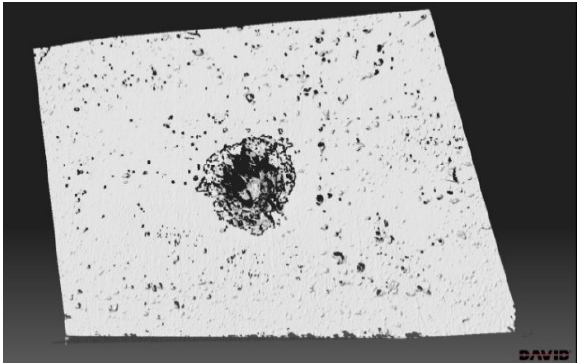
Figure 3. Picture the surface of the board.